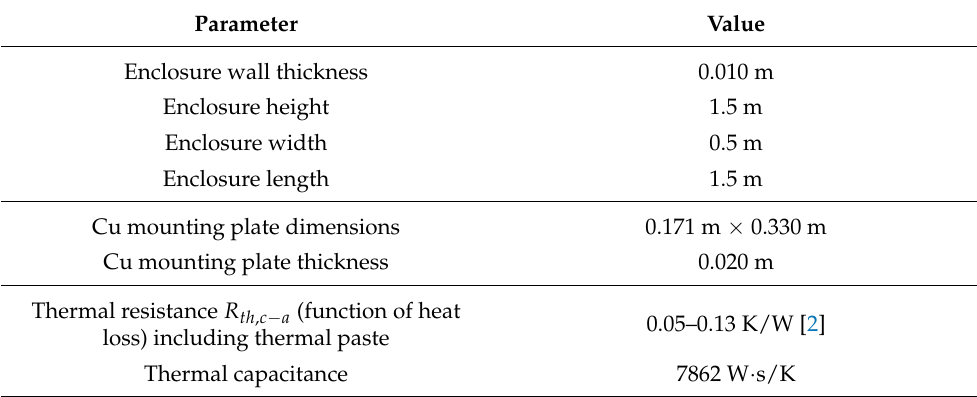
Table 5. Passive water cooling